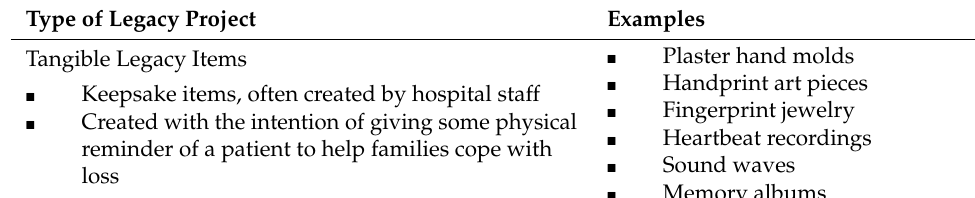
Table 1. Legacy Projects in Pediatric Cancer